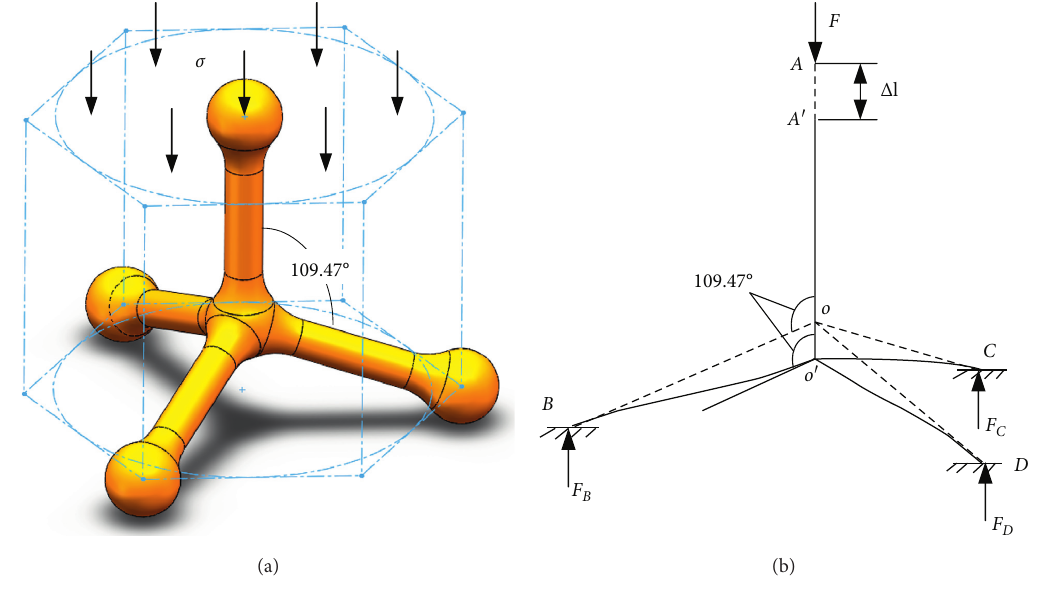
Figure 7: Stress and deformation diagram of structure cell.